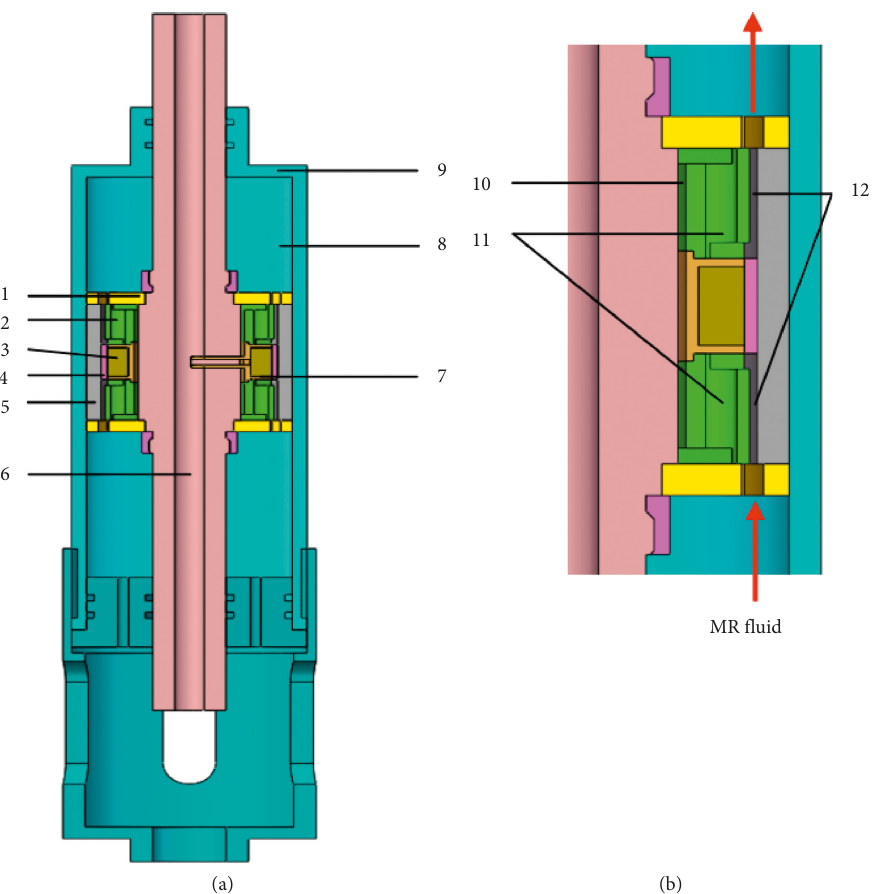
Figure 30: (a) 3D drawing of magnetorheological damper featuring bifold flow mode. (b) Flow channel of MR fluid. 1, piston cover; 2, magnetic core; 3, coil; 4, seal ring; 5, outer piston; 6, inner piston with rod; 7, bobbin; 8, MR fluid; 9, damper housing; 10, inner gap; 11, feedback hole; 12, outer gap [90].